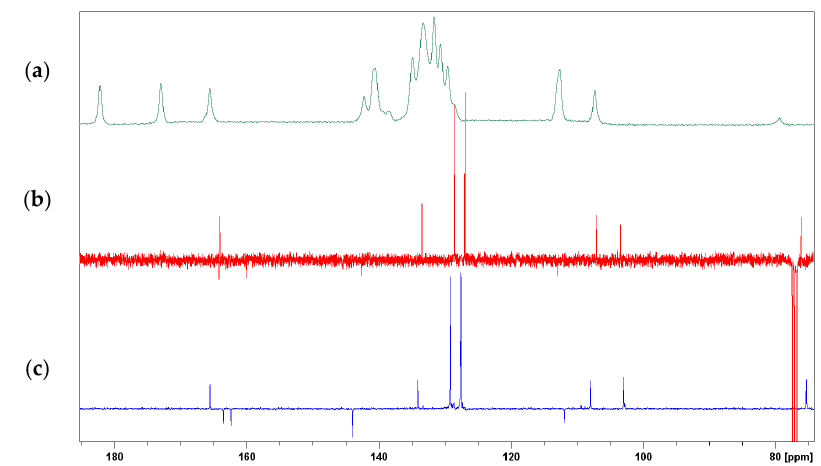
Figure D6. A comparison of solid state 13 C CP-MAS spectrum of mOHsaladpm ( a ) with solution state